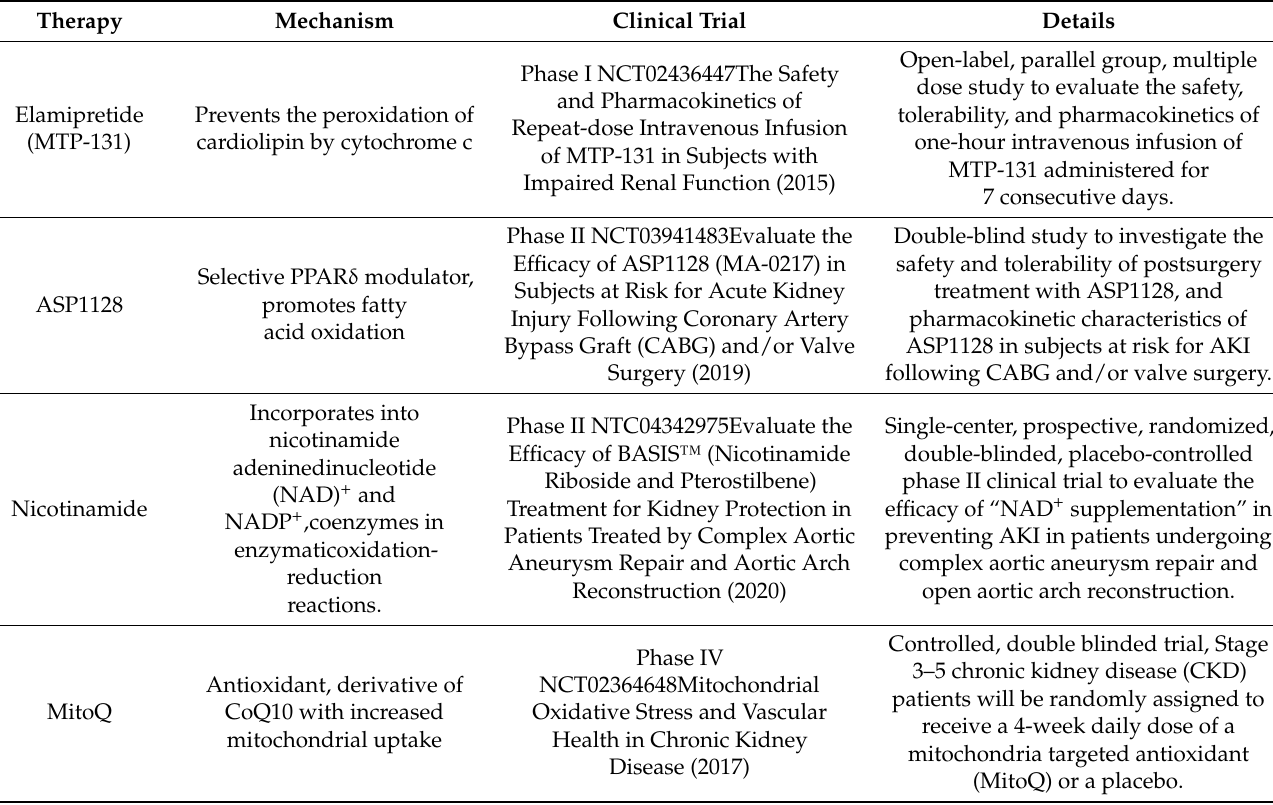
Table 2. Clinical trials with drugs impacting mitochondrial function and